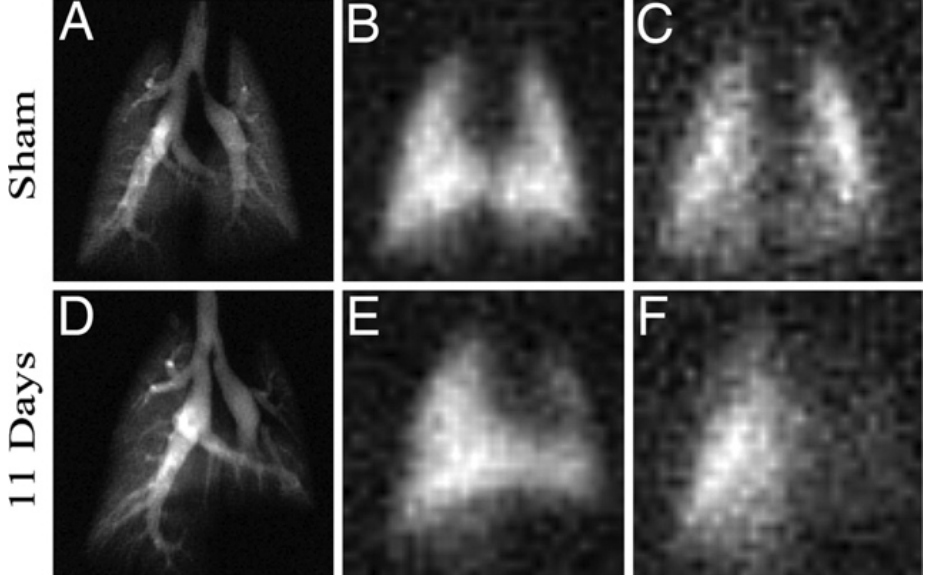
Figure 38. Comparison of HXe images in sham left-lung instilled animal ( A – C ) vs. injured animal with left-lung fibrosis 11 days postinstillation ( D – F ). ( A ) Airspace image in sham. ( B ) Barrier image in sham. ( C ) RBC image in sham. ( D ) Airspace image in injured animal. ( E ) Barrier image in injured animal. ( F ) RBC image in injured animal. Most notable is the nearly complete absence of HXe-RBC intensity in the injured left lung of the diseased animal ( F ), indicating that HXe does not reach the RBCs on the 50-ms image acquisition time scale, likely resulting from increased diffusion barrier thickness. However, note that the barrier images ( B ) and ( E ) closely match the corresponding airspace images ( A ) and ( D ). Reprinted with permission from Driehuys, et al. ( Proc Natl Acad Sci USA 2006, ref.